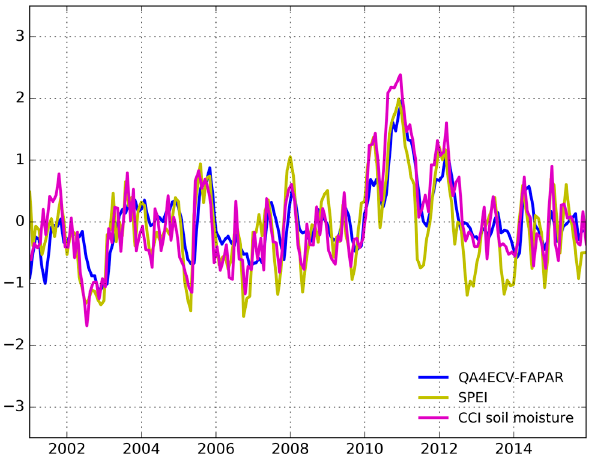
Figure 9. Time series of QA4ECV FAPAR, CCI soil moisture, and SPEI over Murray–Darling Basin, Australia.